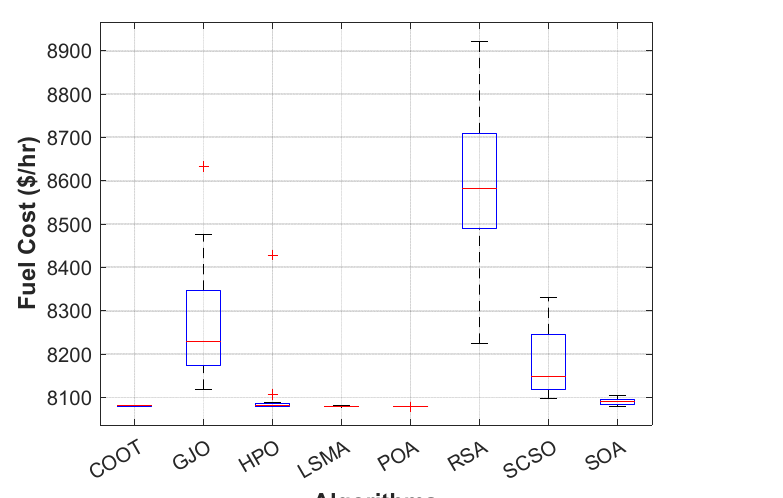
Figure 4. The voltage profile of the POA and other compared algorithms for case 1 in a standard IEEE 14-bus test system.